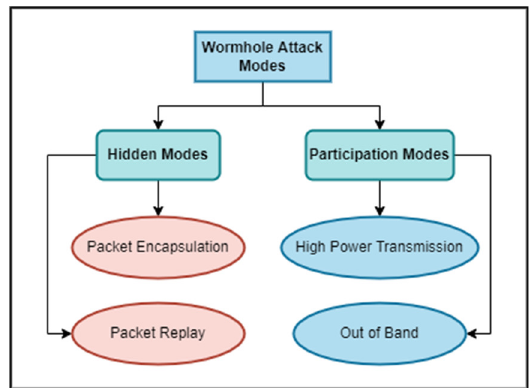
Figure 1. Classification of wormhole attacks based on hidden and participating nodes.